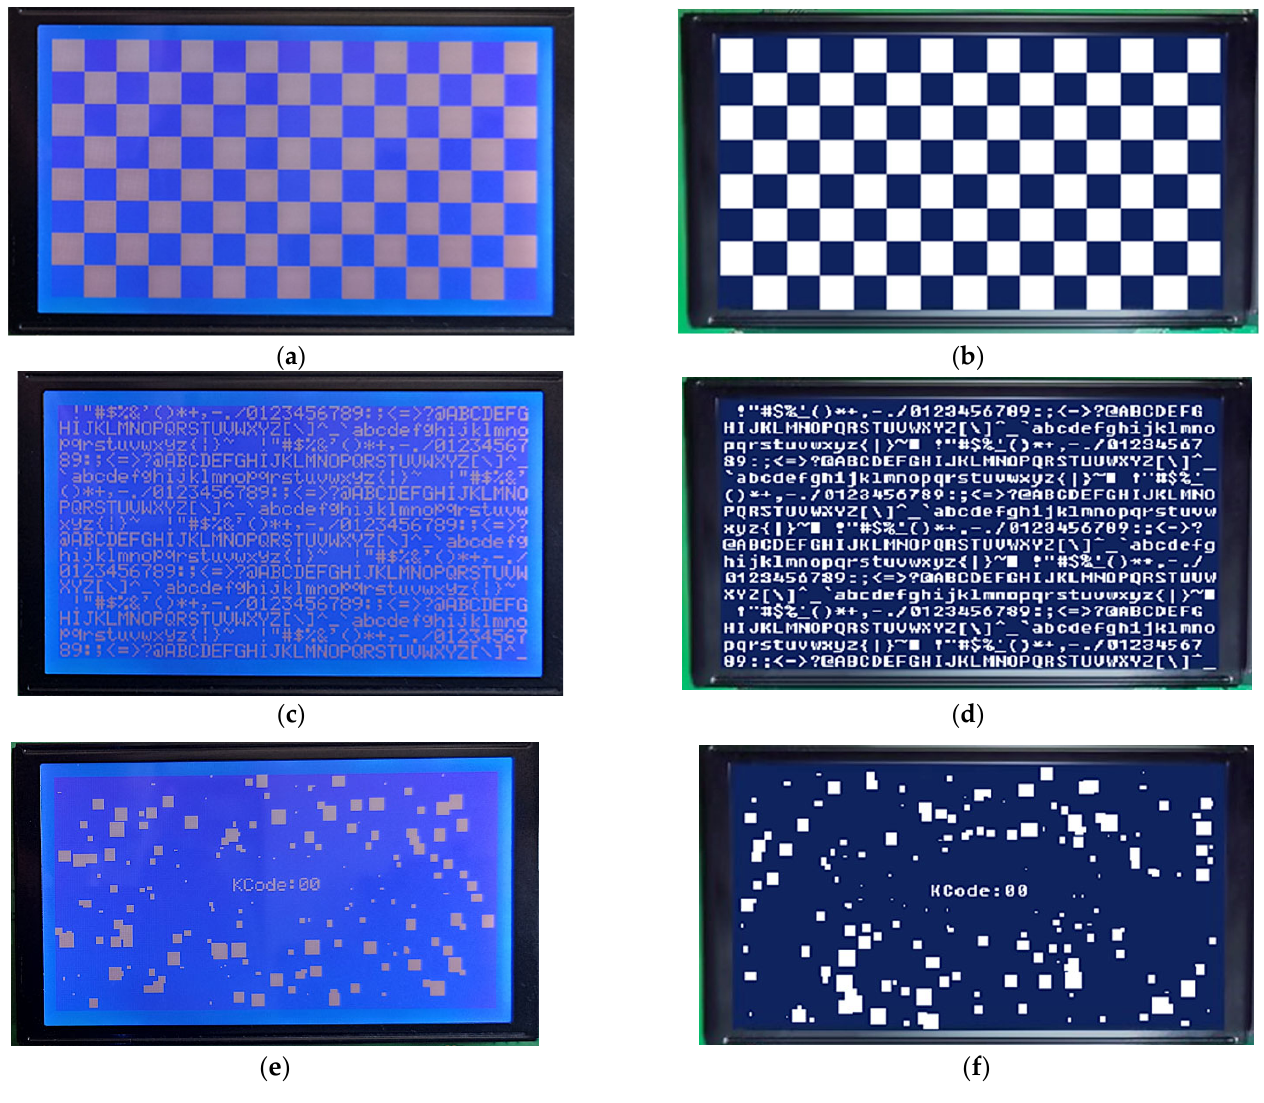
Figure 15. Results of unit tests ( a – d ) and functional tests ( e , f ) performed using TMSLAB real device ( a , c , e ) and its virtual simulator ( b , d , f ): ( a ) photograph of real TMSLAB graphic ‐ layer test; ( b ) screenshot of virtual ‐ simulator graphic ‐ layer test; ( c ) photograph of real TMSLAB textual ‐ layer test; ( d ) screenshot of virtual ‐ simulator textual ‐ layer test; ( e ) photograph of real TMSLAB system ‐ level test; ( f ) screenshot of virtual ‐ simulator system ‐ level test.